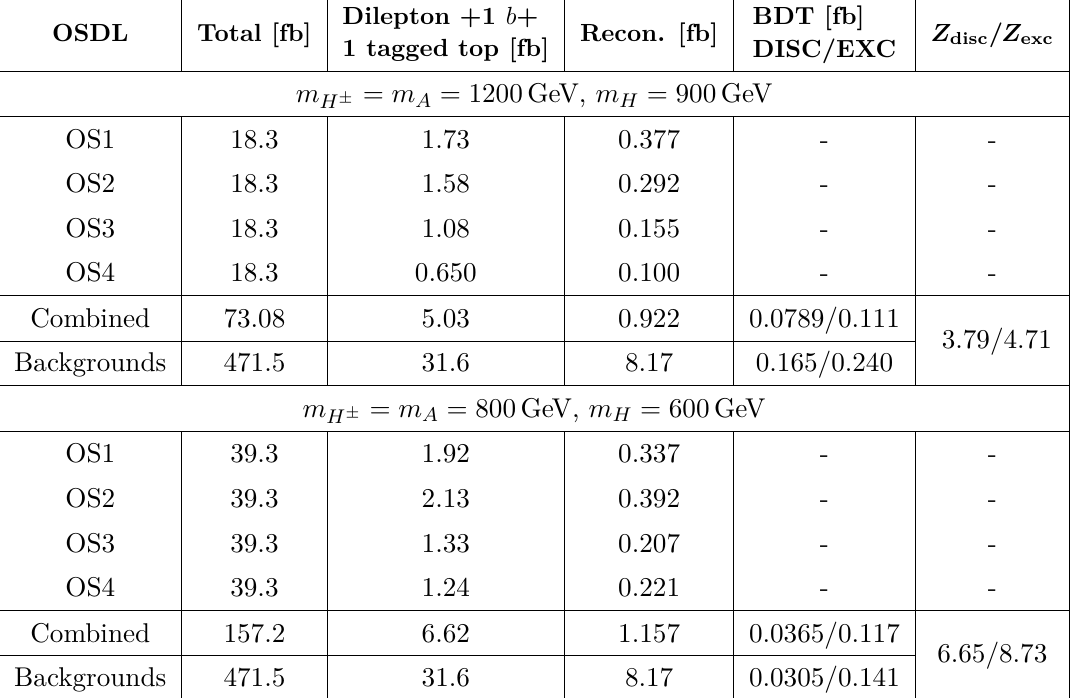
the irreducible backgrounds of tttt and tttbW . The final Z column have already included the 10% systematic